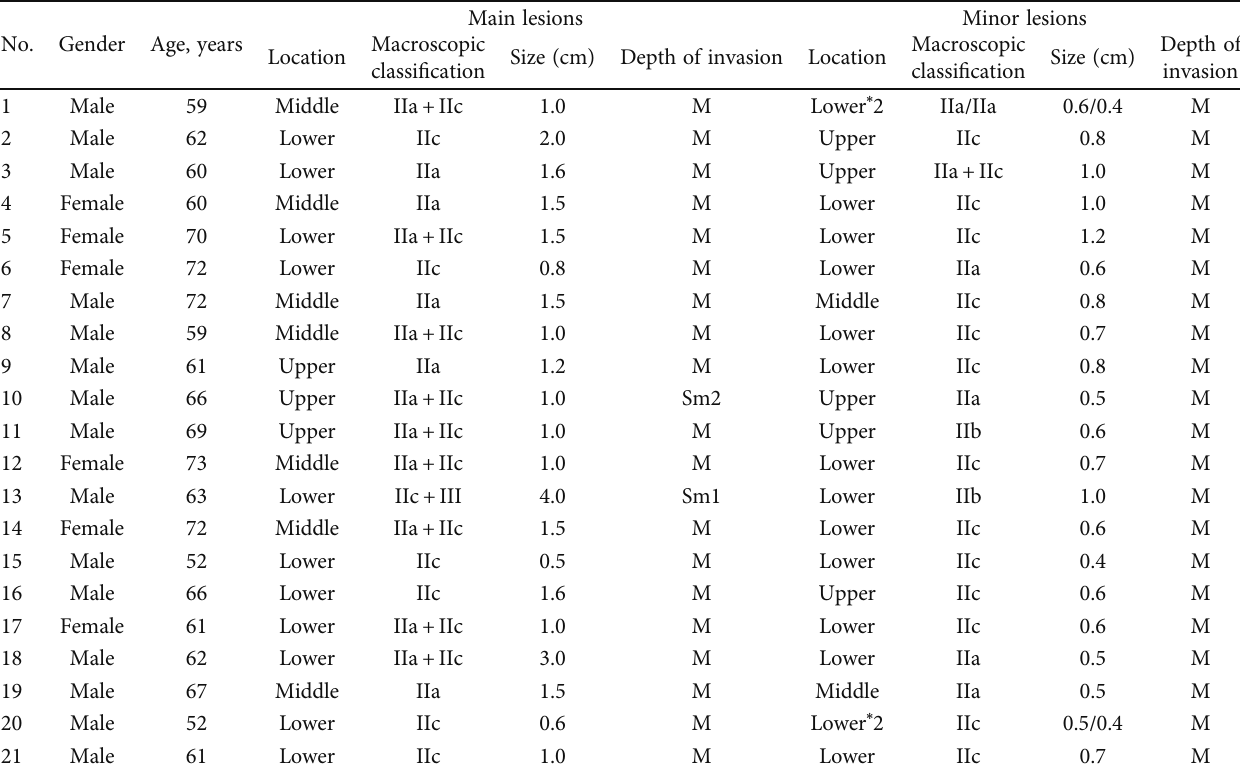
Table 3: SMEGC lesion diagnosed before ESD ( n = 21 ).